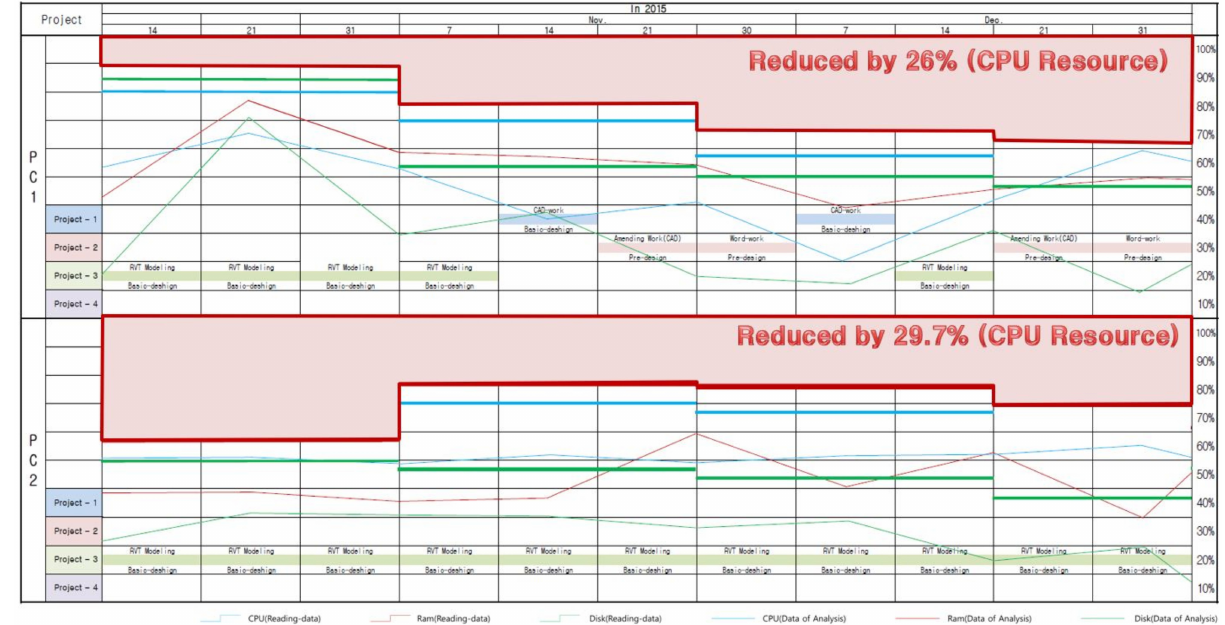
Figure 8. Comparative analysis of the VDI resource value calculated and users’ PC value